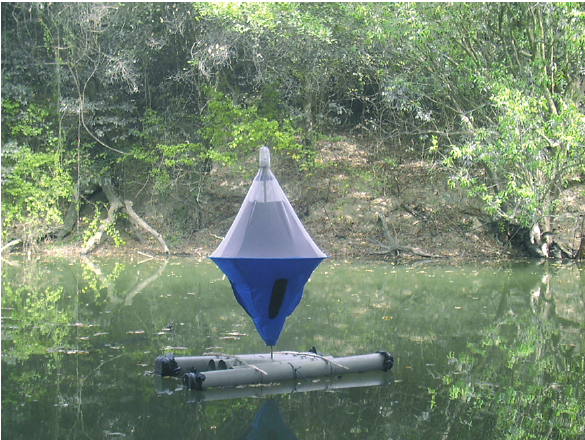
Fig. 1. – Floating Vavoua trap in the mangrove of the Dubreka focus, Guinea.